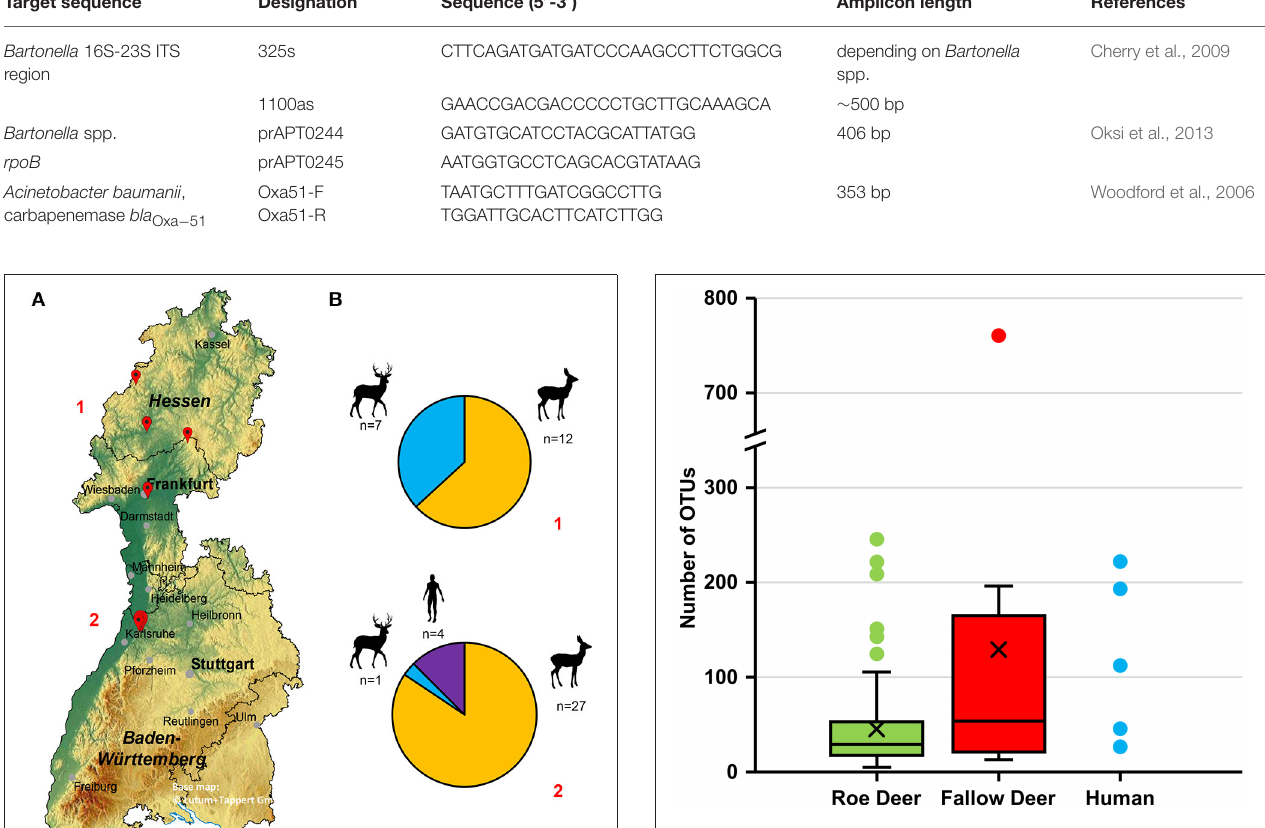
FIGURE 3 | Number of OTUs in deer keds from roe deer, fallow deer and human. Number of operational taxonomic units (OTUs) at a sampling depth of 5,000 reads. Subsampling without replacement was repeated 1,000 times and averages